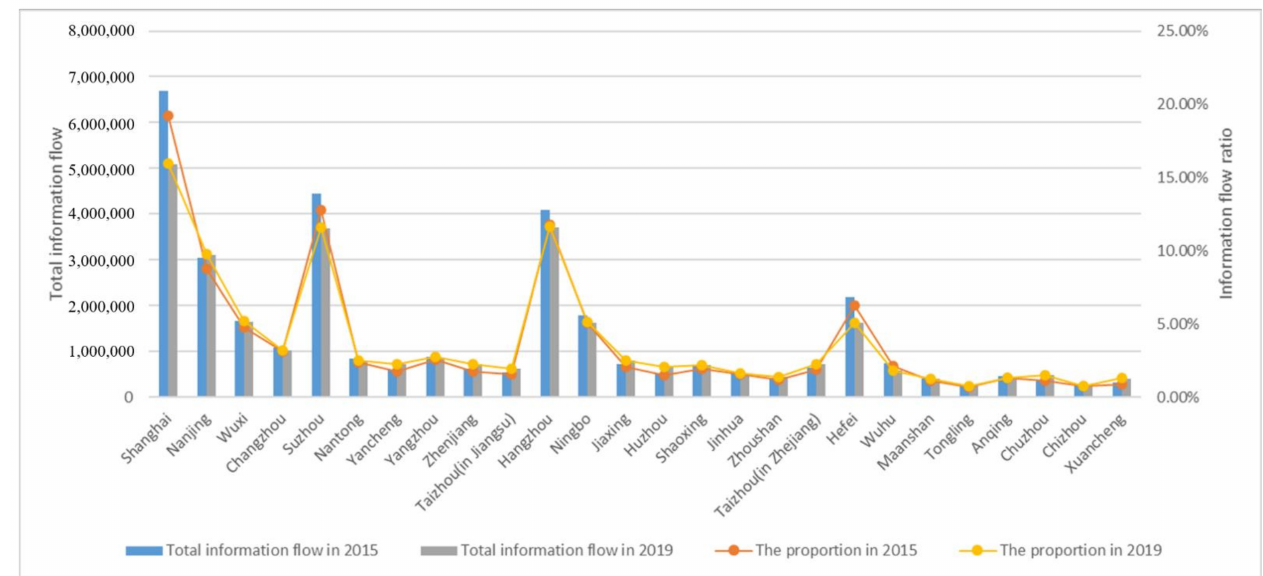
Figure 2. Total information flow and its